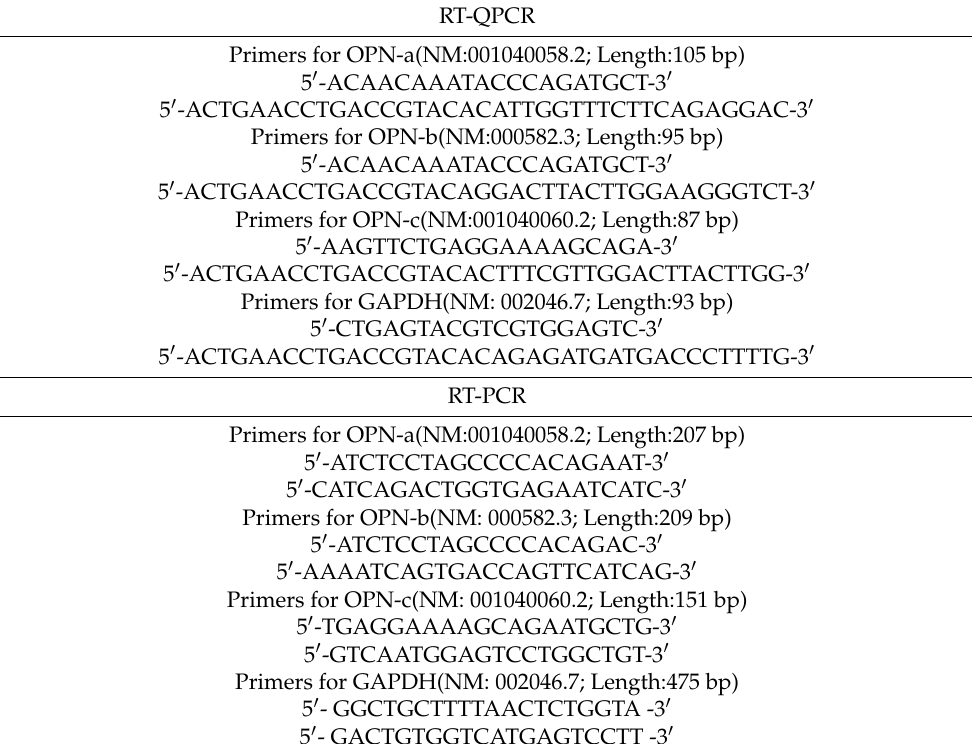
Table 1. Sequences for